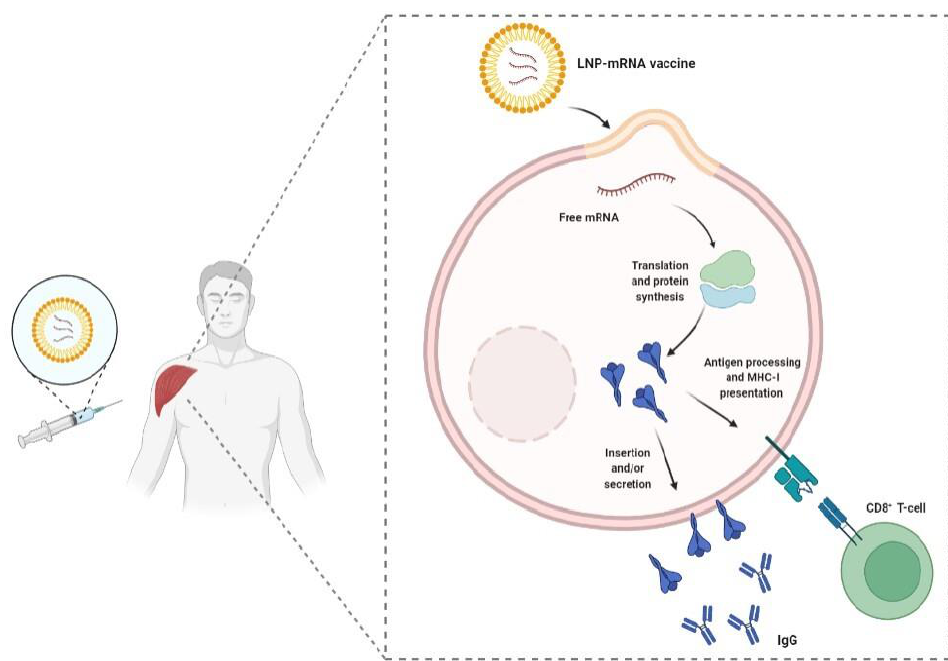
Figure 1. Simplified overview of the mRNA vaccine mechanism of action. Once the mRNA molecule is released from the LNP into the cytosol, it is directly translated by ribosomes into polypeptides. Polypeptides can be processed by the proteasome system, leading to peptide presentation to CD8 + T-cells via MHC I and can also undergo post-translational modifications and be folded into a protein that can either be membrane anchored or secreted to induce antibody production.